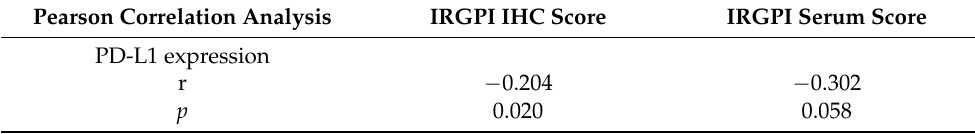
Table 4. Correlations between IRGPI IHC and serum scores and PD-L1 expression.